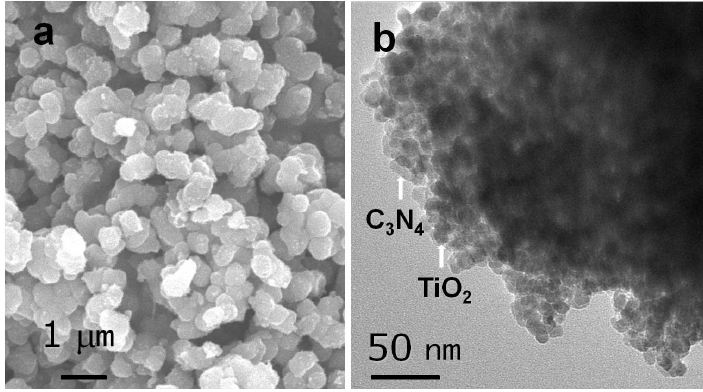
Figure 1. ( a ) Scanning electron microscopy (SEM) image of 0.02 ‐ C 3 N 4 ‐ TiO 2 ; ( b ) transmission electron microscopy (TEM) image of 0.02 ‐ C 3 N 4 ‐ TiO 2